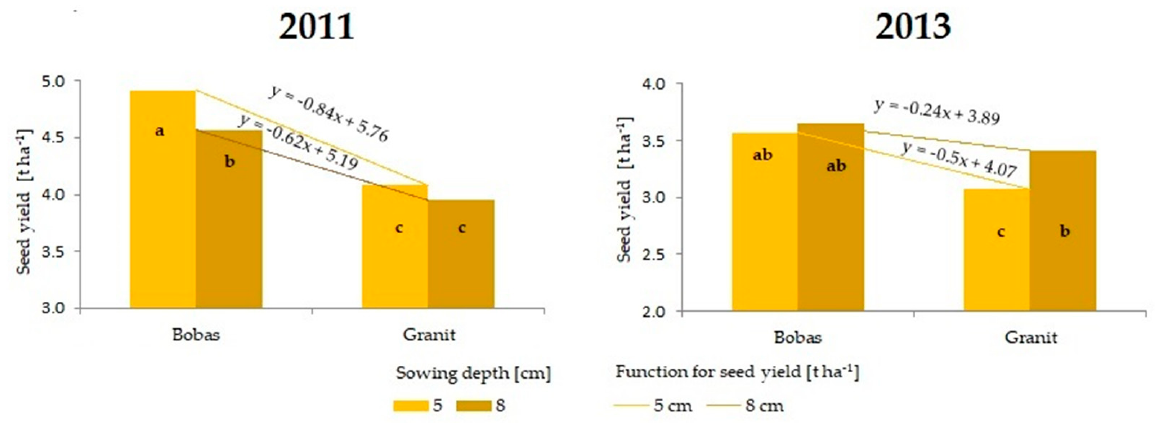
Figure 8. Seed yield in 2011and 2013 (SDH × C). Different letters indicate significant differences between factors (Tukey’s multiple range test).